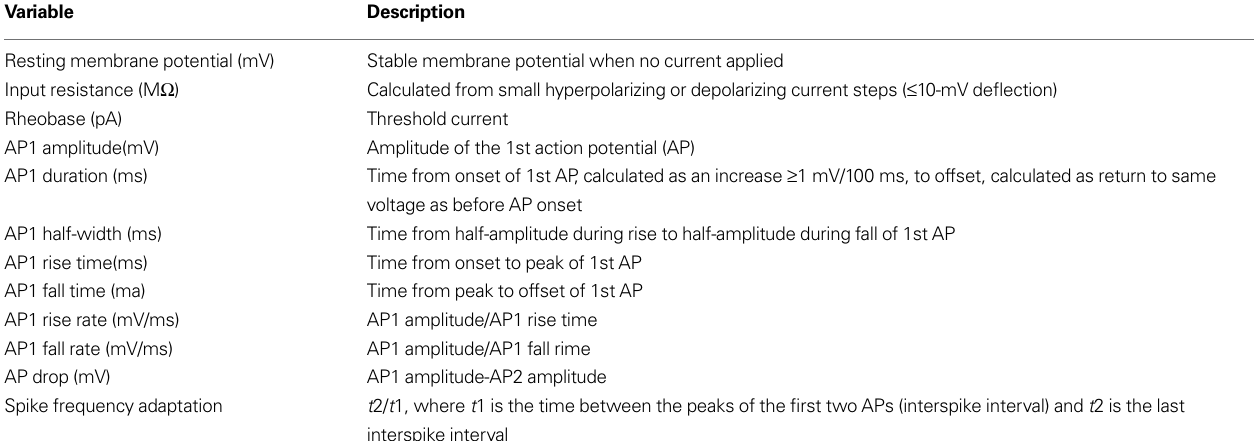
Table 1 | Electrophysiological variables. Action potential properties measured from response to twice threshold, 500-ms current injection from fi rst action potential (AP1) and second action potential (AP2). AP2 variables not listed as the same measurements were made for AP2 as listed for